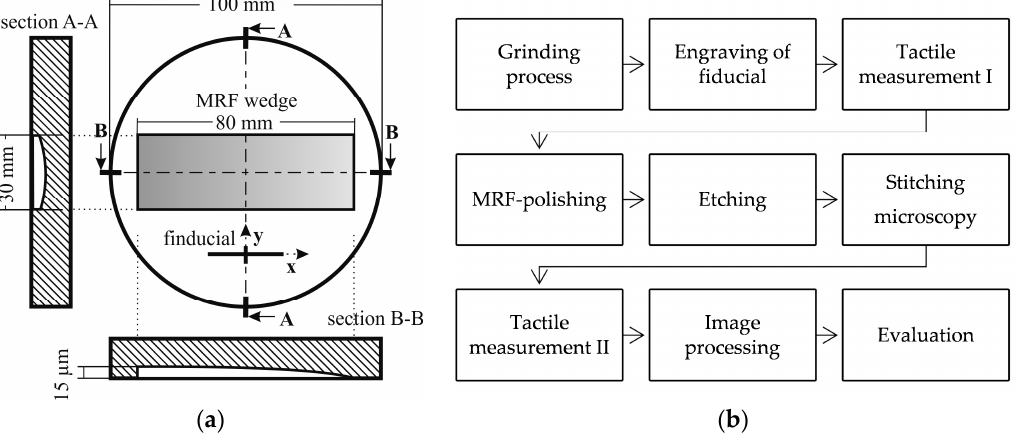
Figure 4. ( a ) Position and geometry of the magnetorheological finishing (MRF) wedge; ( b ) Sample processing chain.